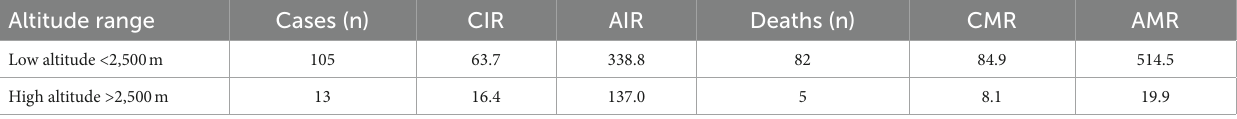
TABLE 2 Distribution of incidence, and mortality rates per 1,000,000 inhabits according to altitude ranges from 2011 to 2021. Altitude